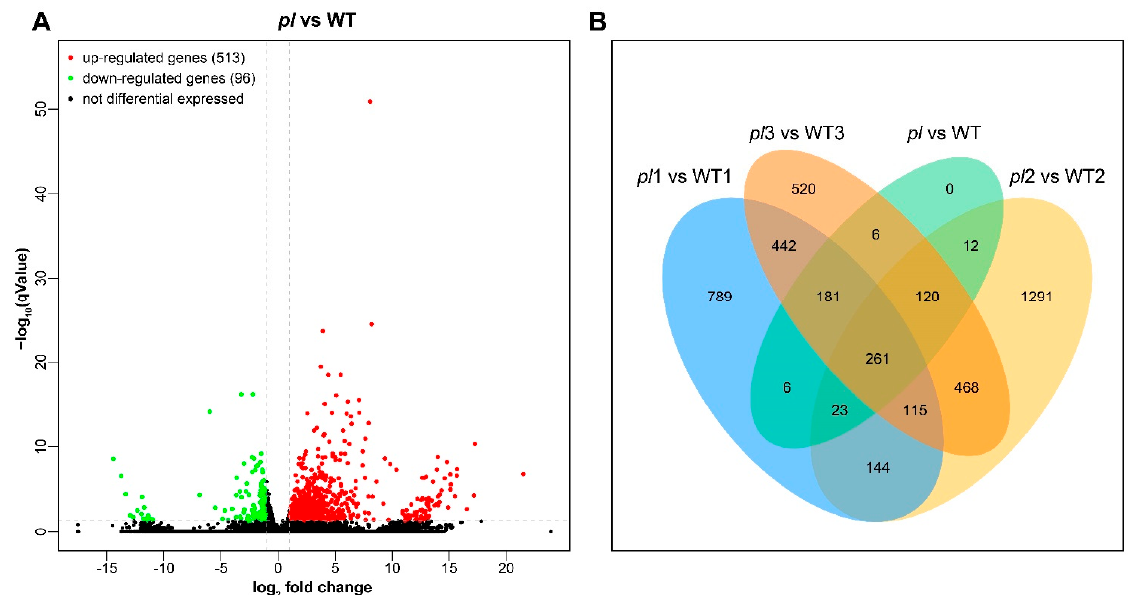
Figure 3. Volcano plot and Venn diagram of DEGs. ( A ) DEGs are presented by volcano map for pl vs. WT. Horizontal axis shows fold-change value (log 2 (B/A)) of the differential expression of the genes in different sample groups, whereas the vertical axis shows the level of significance with p value depicting the changes of gene expression. Every dot in the figure denotes a gene: green as down-regulation, red as up-regulation, and black as non-differentiated genes. ( B ) DEGs for pl vs. WT at grain filling stage are plotted in Venn diagram. Comparisons between different groups are characterized by different colors; numbers in the figure signify the number of shared/specific DEGs. The overlapping regions show the number of shared DEGs by various sets and the non-overlapped regions show the number of unique DEGs.